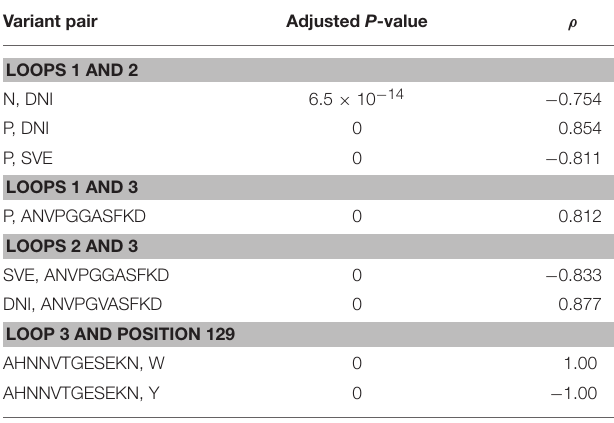
TABLE 4 | Statistically significant co-occurrence of amino acid variations. Variant